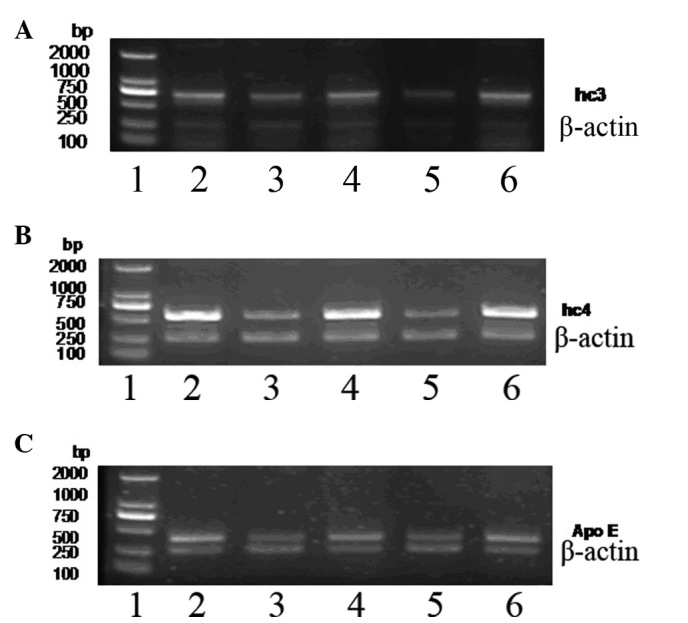
Expression of C3 (hc3), C4b1 (hc4) and ApoE mRNA. Lanes: (1) marker; (2) pancreatic cancer with lymph node metastasis; (3) stage I pancreatic cancer; (4) stage II–IV pancreatic cancer; (5) normal pancreatic tissue; and (6) pancreatic cancer without lymph node metastasis. ApoE, apolipoprotein E.